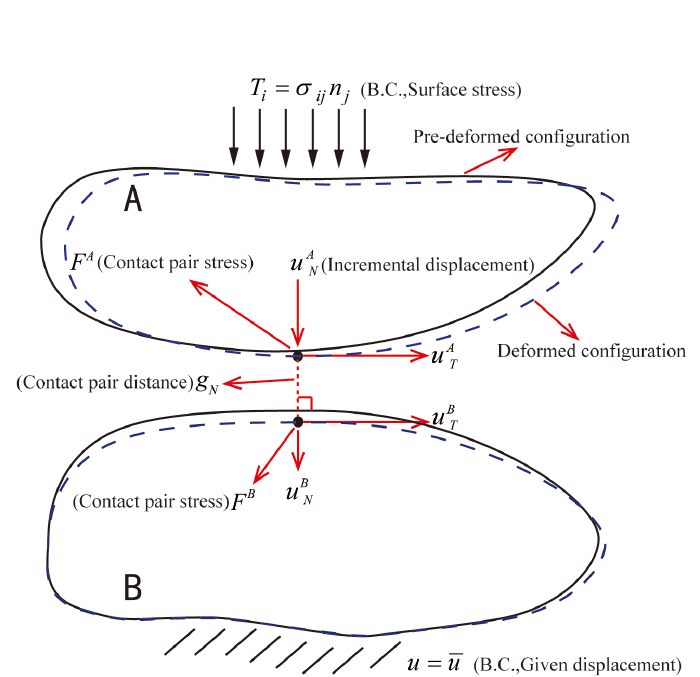
Figure 4. Typical contact problem and boundary